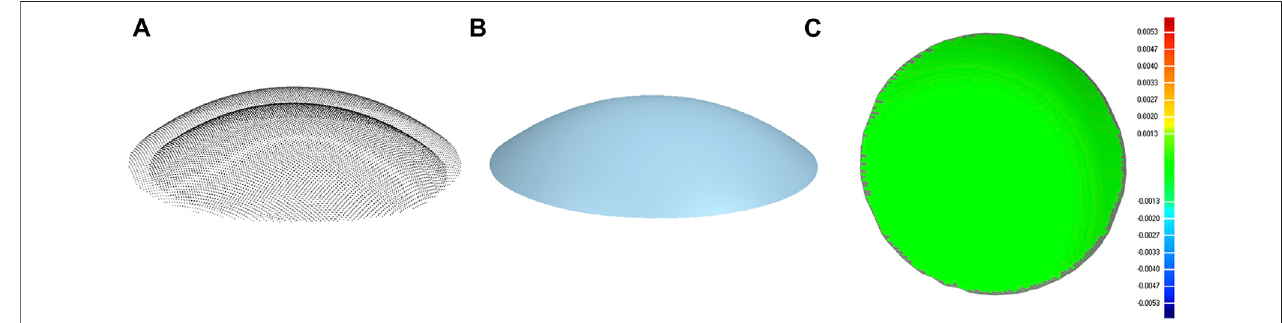
FIGURE2| Cornealsurfacereconstruction. (A) Cloudofpointsoftheanteriorandposteriorcornealsurface. (B) Geometricalmodelofthecornea. (C) Contourmap of the error between the point cloud data and corneal geometrical model (both anterior and posterior corneal